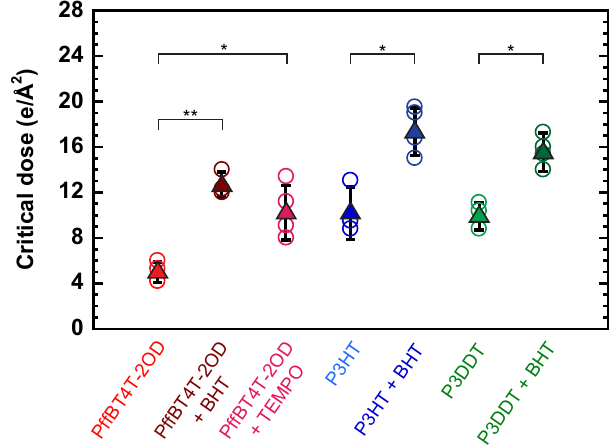
Fig. 2 Critical doses of PffBT4T-2OD, P3HT, and P3DDT with and without antioxidant at room temperature. The addition of 7 wt% antioxidant increases the critical dose of conjugated polymers at 1 e/Å 2 s. BHT is most effective at minimizing damage in PffBT4T-2OD. BHT appears to be more effective at minimizing damage than TEMPO. Average values are shown as fi lled triangles and individual data points are shown as empty circles. Error bars are the standard deviation of multiple measurements ( n ~ 3). Two sample, one-tailed p-values are shown as p < 0.05 ( ∗ ) and p < 0.01 ( ∗∗